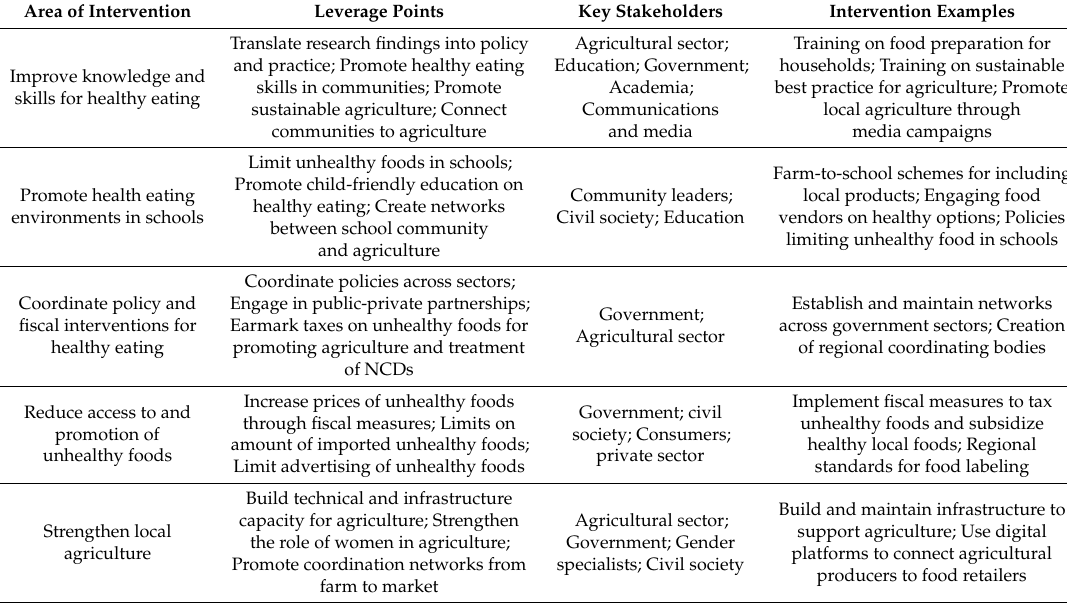
Table 3. Prioritized list of areas for intervention, intervention leverage points, and identified key stakeholders for Jamaica and St. Kitts and Nevis and St. (SKN / SVG)